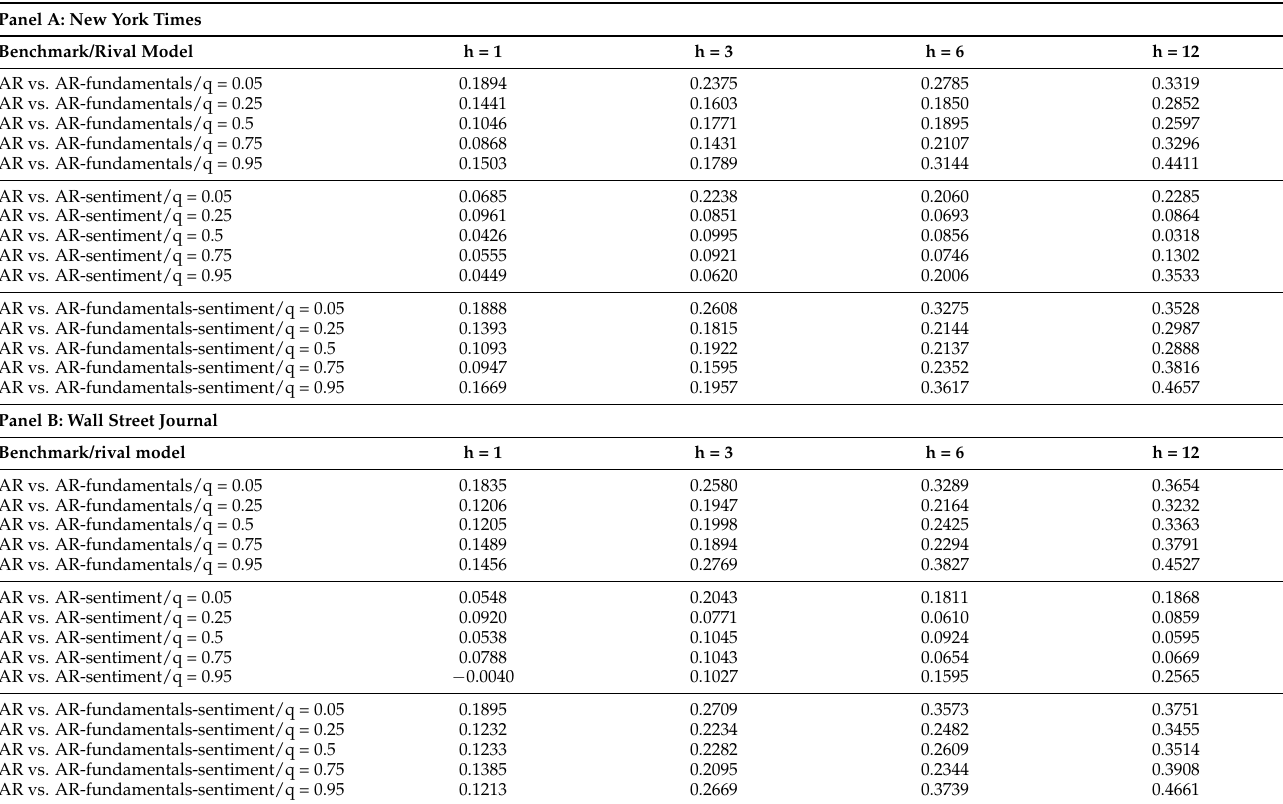
Table 1. AR model is the